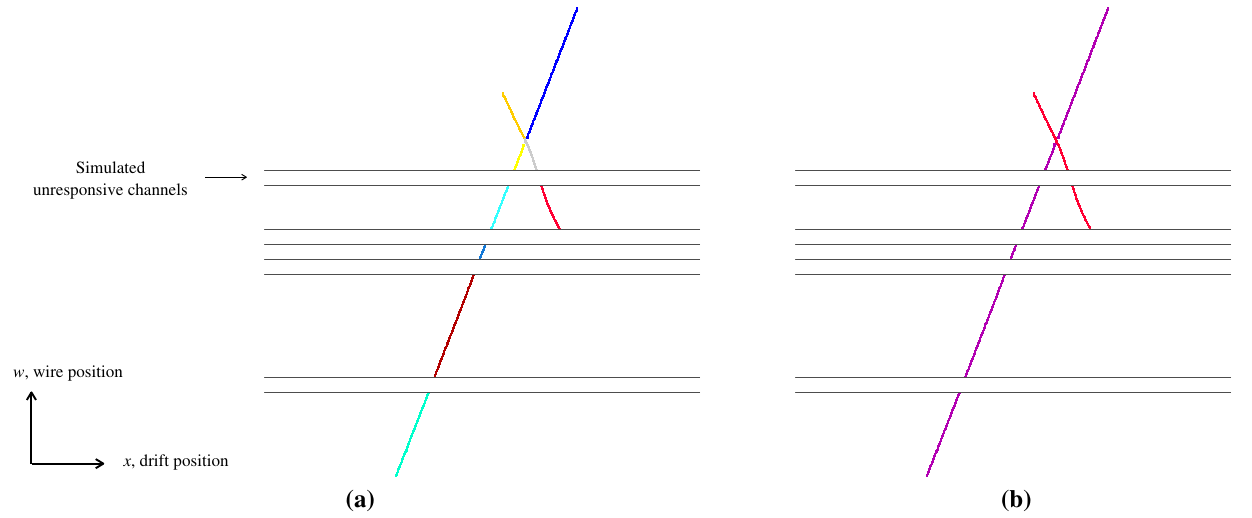
Fig. 3 a Clusters produced by the TrackClusterCreation algorithm for two crossing cosmic-ray muons in the MicroBooNE detector simula- tion. Separate clusters are formed where the tracks cross and on either side of unresponsive regions of the detector. b The refined clusters